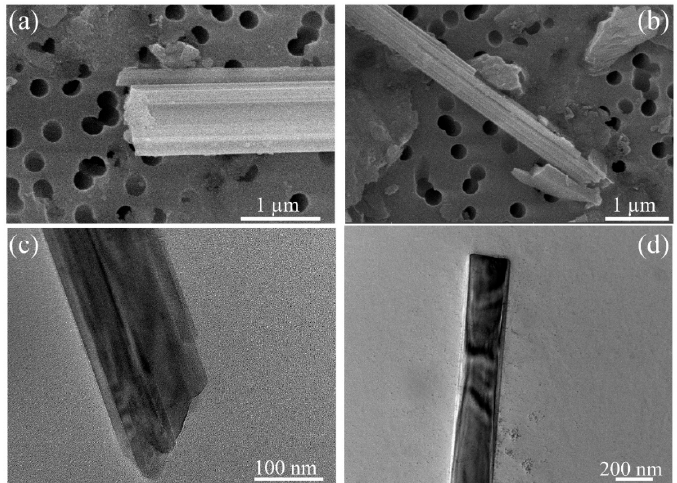
Figure 3. ( a ) High-resolution FEG-SEM image of an amosite fibre; ( b ) high-resolution FEG-SEM image of bundles of crocidolite fibres; ( c ) TEM image of a crocidolite fibre with stepped edges; ( d ) TEM image of an individual crocidolite fibre showing characteristic diffraction contours. Table 1. Morphometry of the coated and non-coated fibres recovered from the studied lung tissue. * Percentile indicates the value below which a given percentage of values in a data set fall. L (length); W (width); Min (minimum); Max (maximum); σ n − 1 (standard deviation).